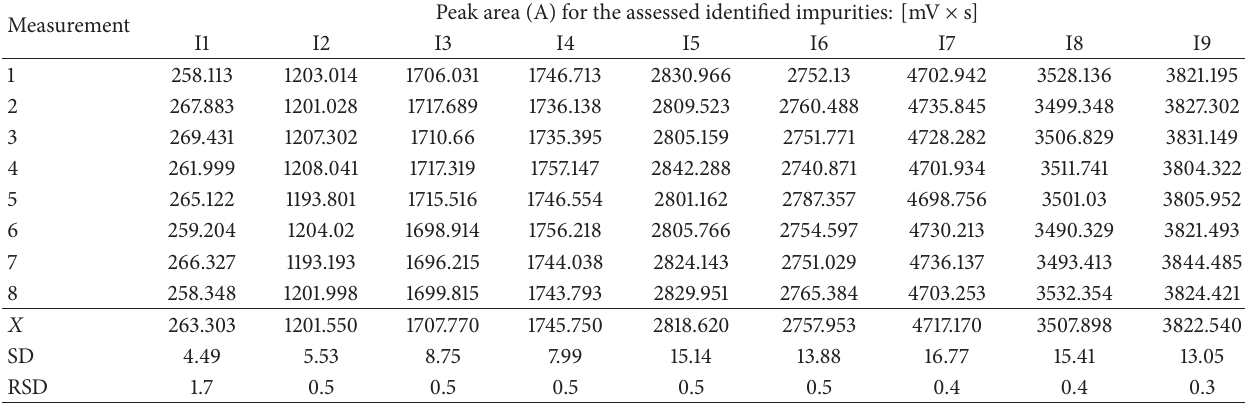
Table 1: Results of the assessment of the precision of the chromatographic system due to the assessments of nine identified impurities of the azelaic acid.